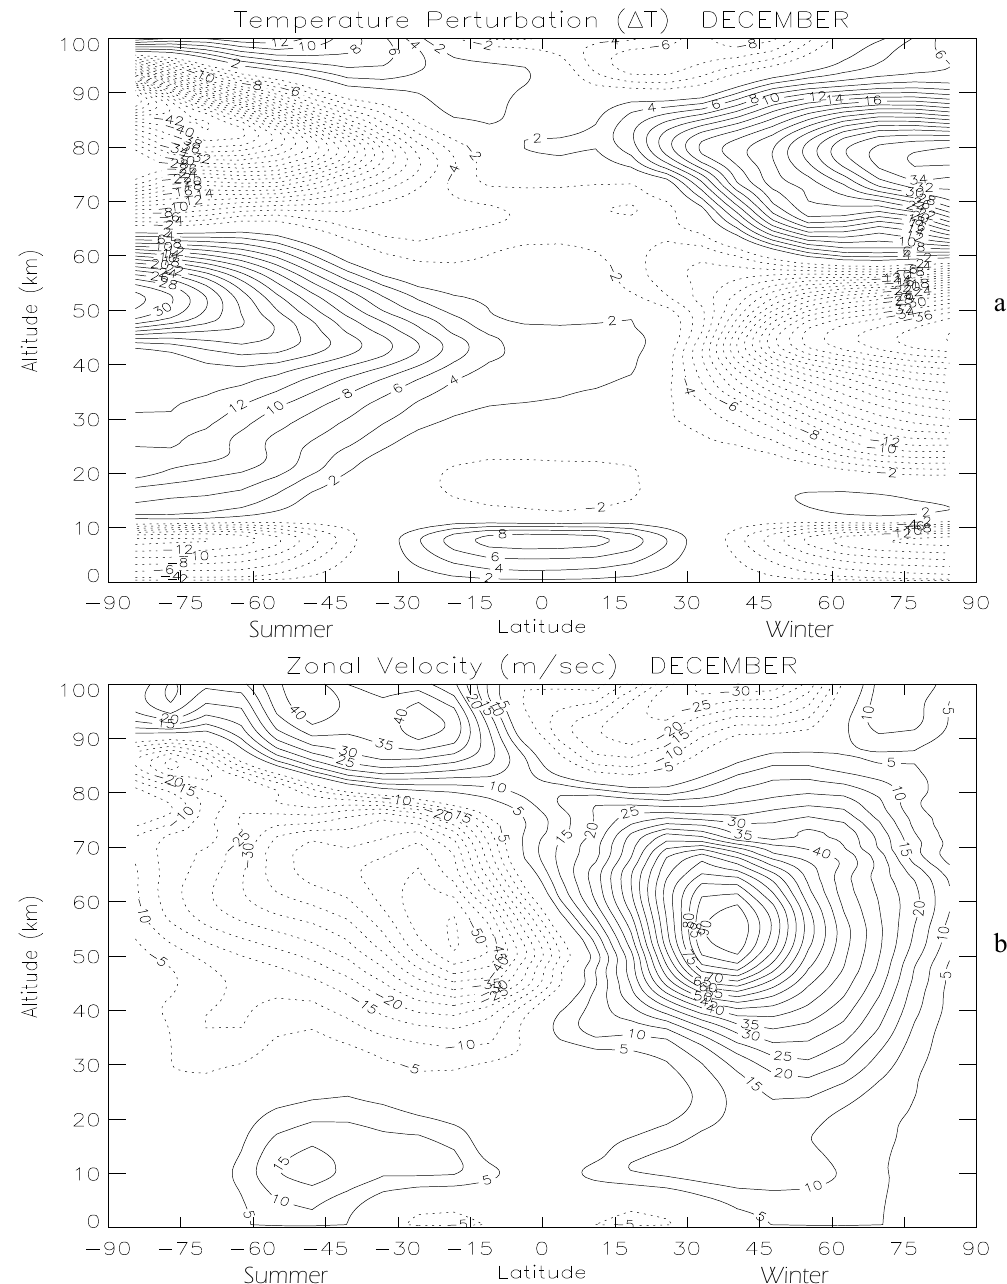
Fig. 1. Zonal-mean (m=0) temperature perturbations ( a ) and zonal winds ( b ) , which are computed with the tropospheric heat source. The contour plots are derived by averaging December solstice conditions for five consecutive years. Above the tropopause and 65km, the reversals in the latitudinal temperature gradients significantly affect the pressure and density gradients, and this contributes to producing the instabilities that generate the PWs in the